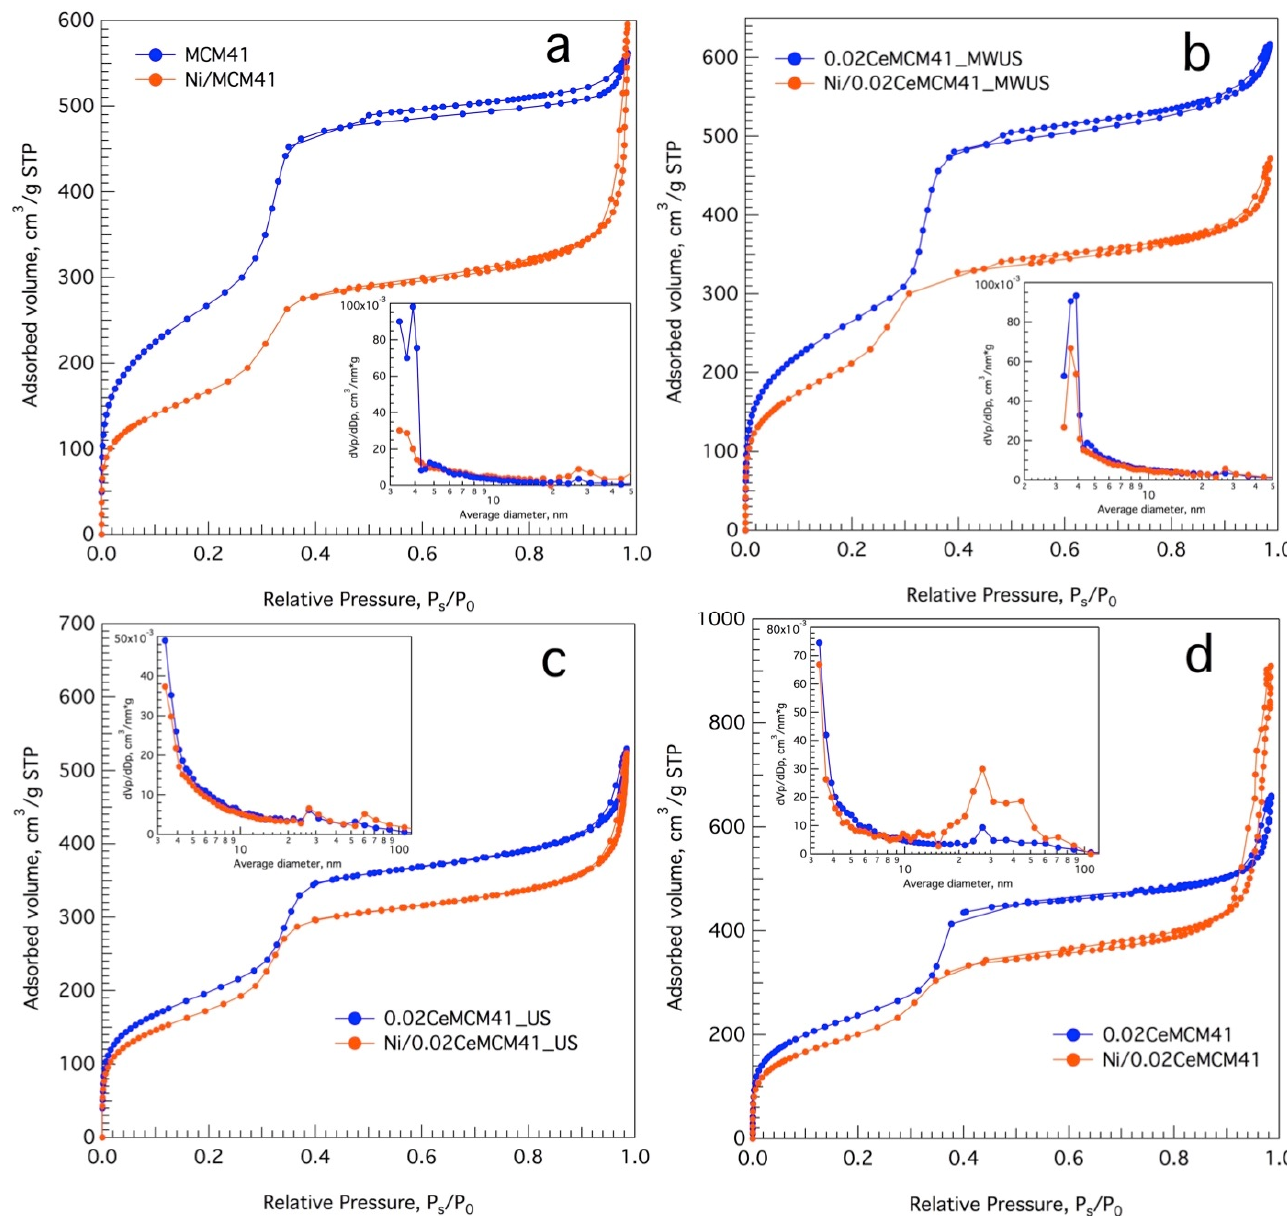
Figure 5. N 2 isotherms for nickel catalysts (10% wt) over Ce-promoted mesoporous silica sieves: ( a ) MCM-41; ( b ) 0.02Ce-MCM-41_MWUS; ( c ) 0.02Ce-MCM-41_US and ( d ) 0.02Ce-MCM-41 (blue curves: bare supports; orange curves: Ni catalysts; insets: BJH pore size distribution graphs for both samples).